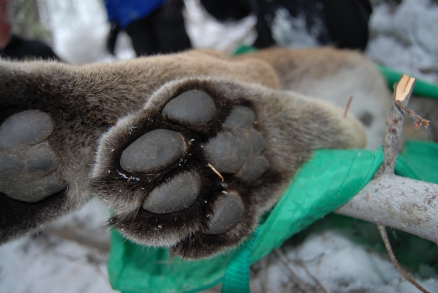
A Cougar PawCougars tend to keep their claws retracted when not in use, which is why their tracks leave no claw marks. A large male kills on average one deer or elk every week to 12 days and may stalk its prey for an hour or more, then attack with a sudden burst of speed, aiming for a quick kill by breaking the animal's neck. (Rich Beausoleil, WDFW)